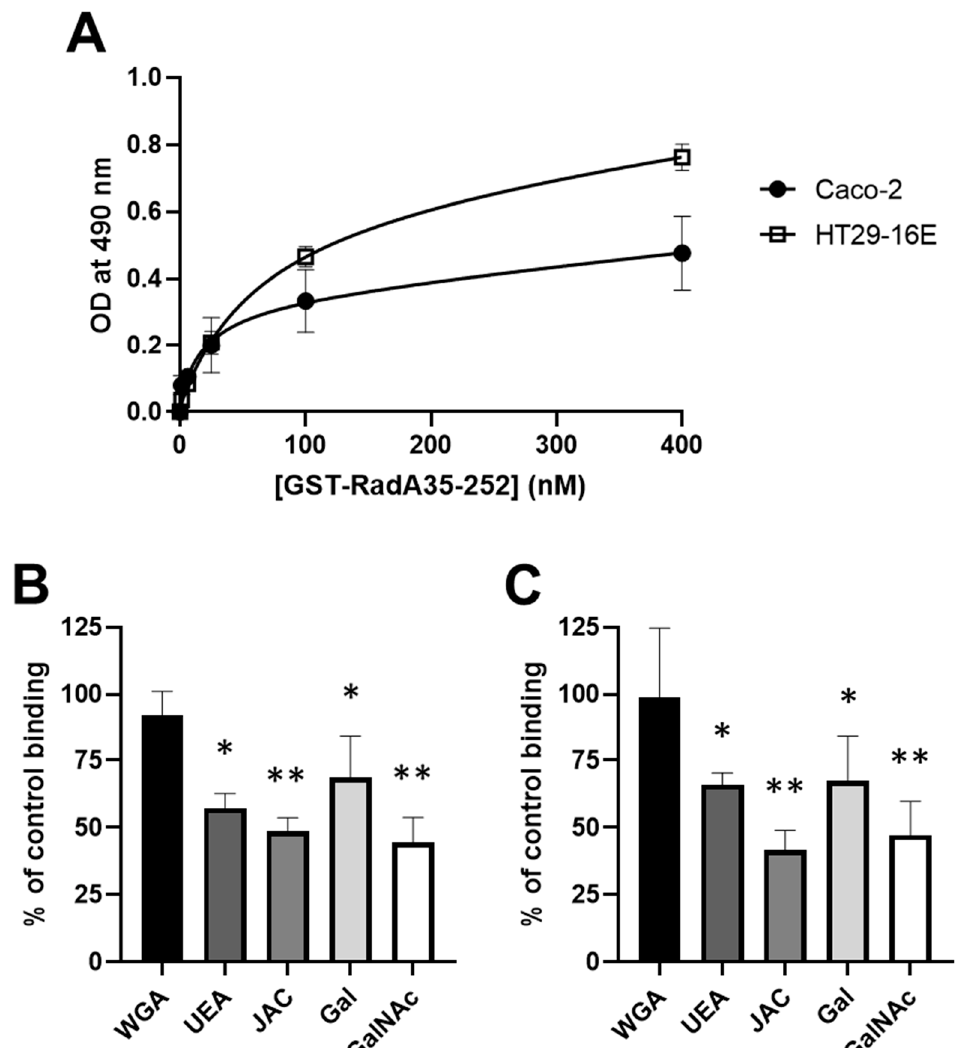
Figure 9. GST-RadA 35-252 binds to the surface of human intestinal epithelial cells. Caco-2 and HT29-16E cells were used to study the dose-dependent binding of GST-RadA 35-252 to human intestinal cells ( A ). The inhibitory effect of lectins and monosaccharides on the binding of RadA 35-252 to Caco-2 cells ( B ) or HT29-16E cells ( C ) was studied as indicated in the Materials and Methods. Results are expressed as means ± S.D. *: p < 0.05, **: p < 0.01 ( n = 3).